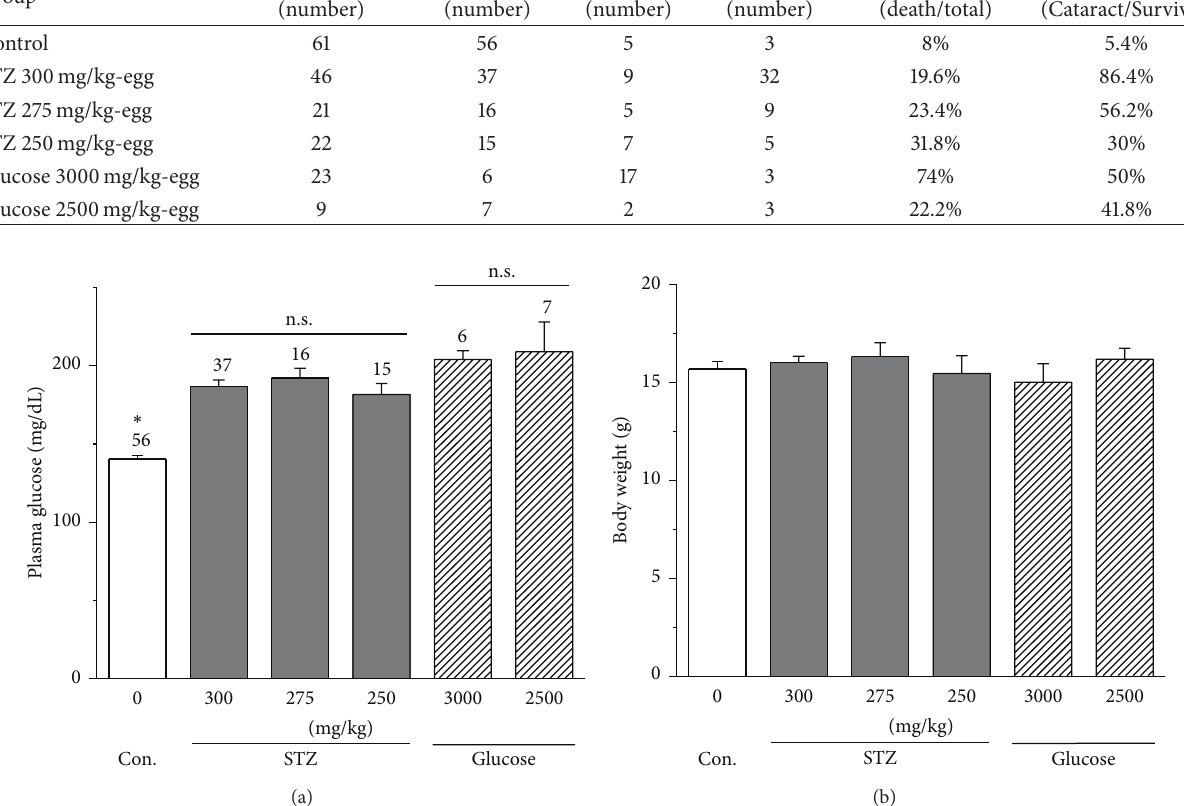
Figure 1: STZ- or high glucose-injected embryos have elevated plasma glucose levels without changes in body weights. (a) At E12, embryos were injected with either STZ (300, 275, or 250), high glucose (3,000 or 2,500) mg per kg of egg weight (mg/kg), or vehicle (control). All STZ- and high glucose- injected embryos at E18 had significantly higher plasma glucose levels compared to the control (CON). (b) There is no statistical difference in body weight among all groups. ∗ 𝑃 < 0.05 . n.s.: no statistical